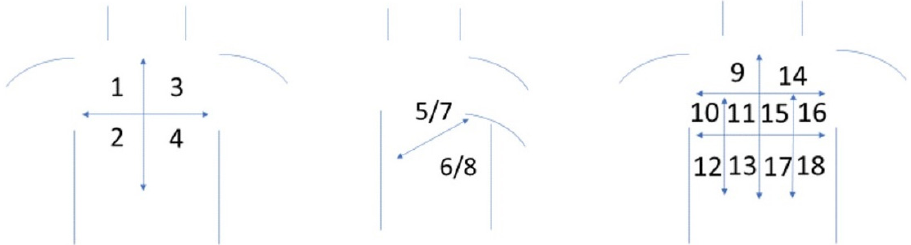
Figure 1. Schematic drawing showing the division of the thorax into pulmonary fields (from 1 to 18), which were assessed equally on lung ultrasound and HRCT (1—right side, upper-anterior field, 2—right side, lower-anterior field, 3—left side, upper-anterior field, 4—left side, lower-anterior field, 5—right side, upper-lateral field, 6—right side, lower-lateral field, 7—left side, upper-lateral field, 8—left side, lower-lateral field, 9—left side, upper-posterior field, 10—left side, middle field, 11—left side, middle-paravertebral field, 12—left side, lower field, 13—left side, lower-paravertebral field, 14—right side, upper-posterior field, 15—right side, middle-paravertebral field, 16—right side, middle field, 17—right side, lower-paravertebral field, 18—left side, lower field).